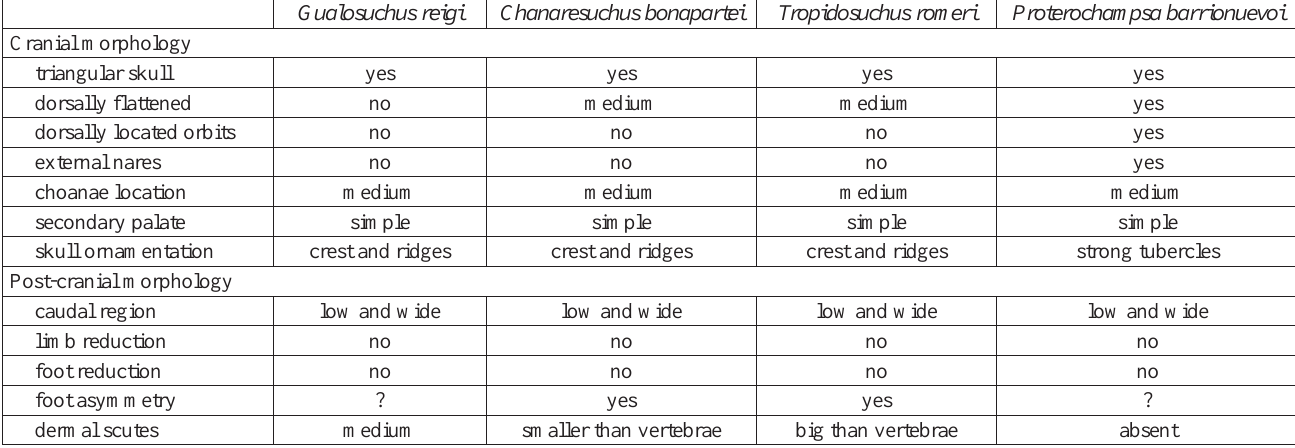
Table 1. Main morphological features of proterochampsids from Chañares and Ischigualasto Formation mentioned in the text (from Arcucci 2011; Troteyn et al.